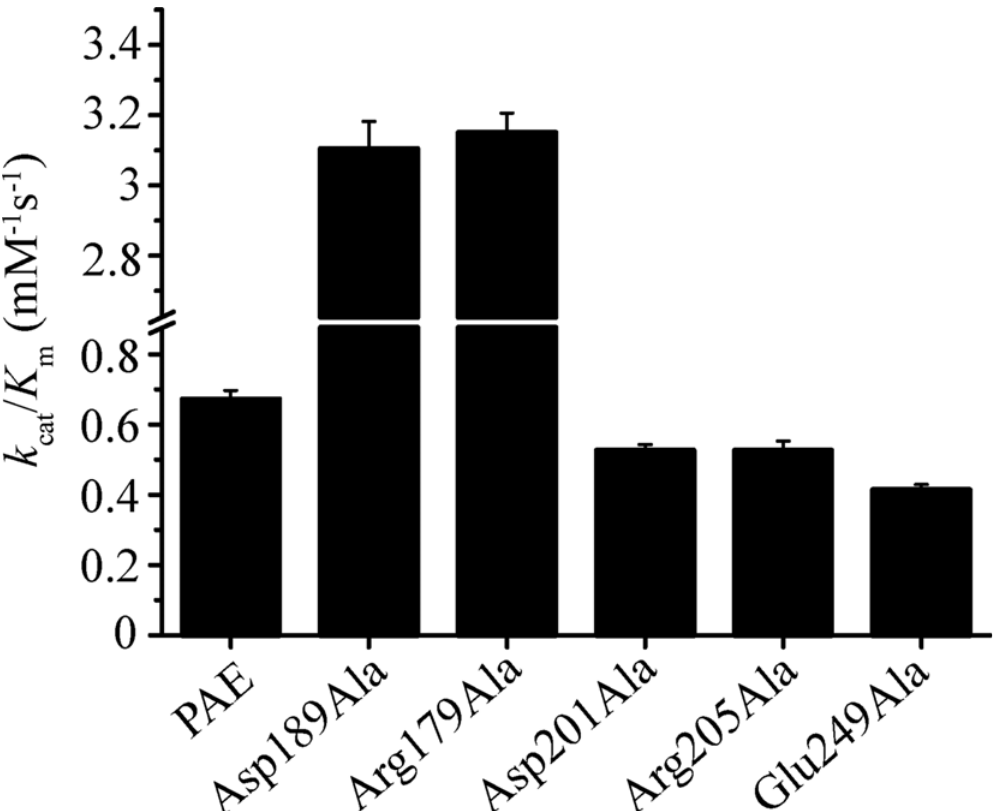
Fig 3. Specific constant k cat / K m values of PAE and the active mutants. The k cat / K m values were measured at 25°C with FAGLA as the substrate. Mutant Arg179Ala was purified after a 12-h incubation. The other mutants were purified after a 2-h incubation. Each measurement was repeated three times, and all of the standard deviations were within 5% of the corresponding mean